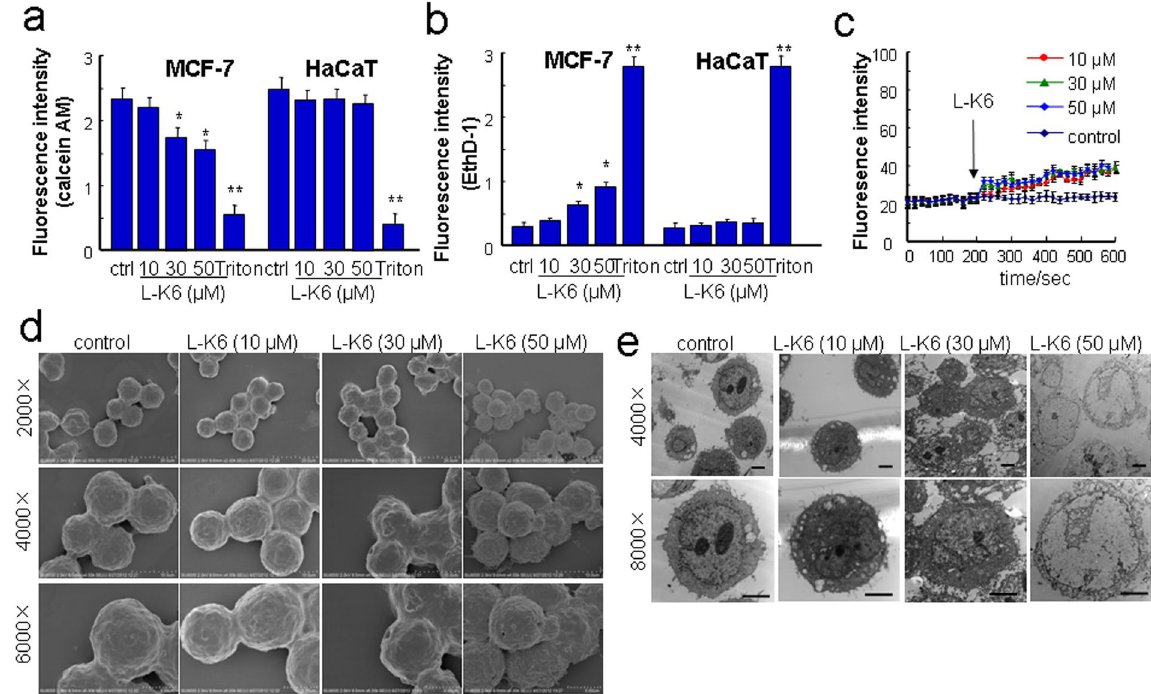
Figure 2. L-K6 at higher concentrations preferentially elevated cancer cell membrane permeability. To evaluate the possible impacts of L-K6 on cell membrane permeability, a calcein/EthD-1 leakage assay was performed. L-K6 administration (especially 30~50 μ M) induced a significant change in membrane permeability of MCF-7 cells, as indicated by the decreased fluorescence intensities of calcein ( a ) and increased EthD-1 ( b ). Additionally, L-K6-induced elevation of membrane permeability was cancer-specific, as evidenced by stable fluorescence intensities of calcein and EthD-1 in HaCaT cells ( a , b ). Consistent with calcein/EthD-1 leakage assay, the membrane depolarization assay further supported the elevated membrane permeability (mean ± SD) as indicated by the increased DiBAC 4 (3) fluorescence intensity after peptides exposure ( c ). Morphological changes of human MCF-7 breast cancer cells induced by L-K6 as assessed by scanning electron microscopy ( d ) and transmission electron microscopy ( e ). * p < 0.05, ** p < 0.01 vs. untreated control group. All experiments had been performed in